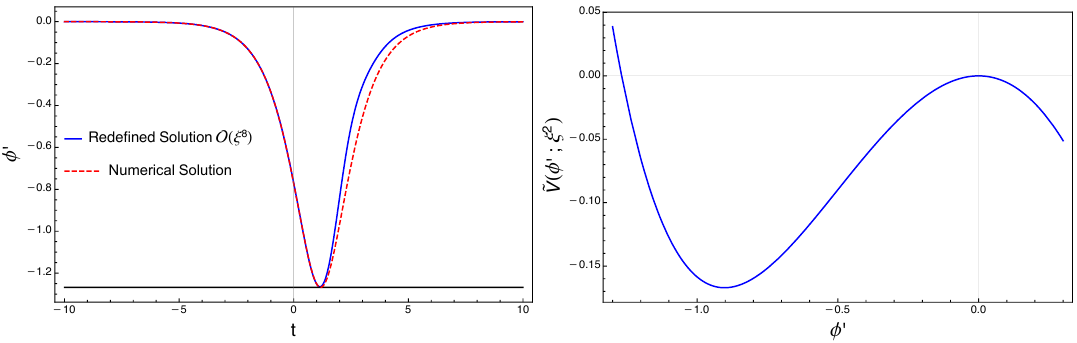
Figure 4 . Plots calculated to O ( ξ 8 ) and setting ξ = 0 . 3 . Left: the redefined solution φ 0 ( t ) compared to the rolling solution in ˜ V ( φ 0 ; ξ 2 ) . The black line denotes the value φ 0 ’ − 1 . 27 of the turning point in ˜ V ( φ 0 ; ξ 2 ) . Neither solution overshoots this turning point. Right: the potential ˜ V ( φ 0 ; ξ 2 )